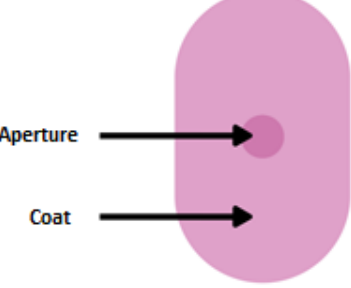
Figure 6. Scheme illustration of DiffCORE™ system.